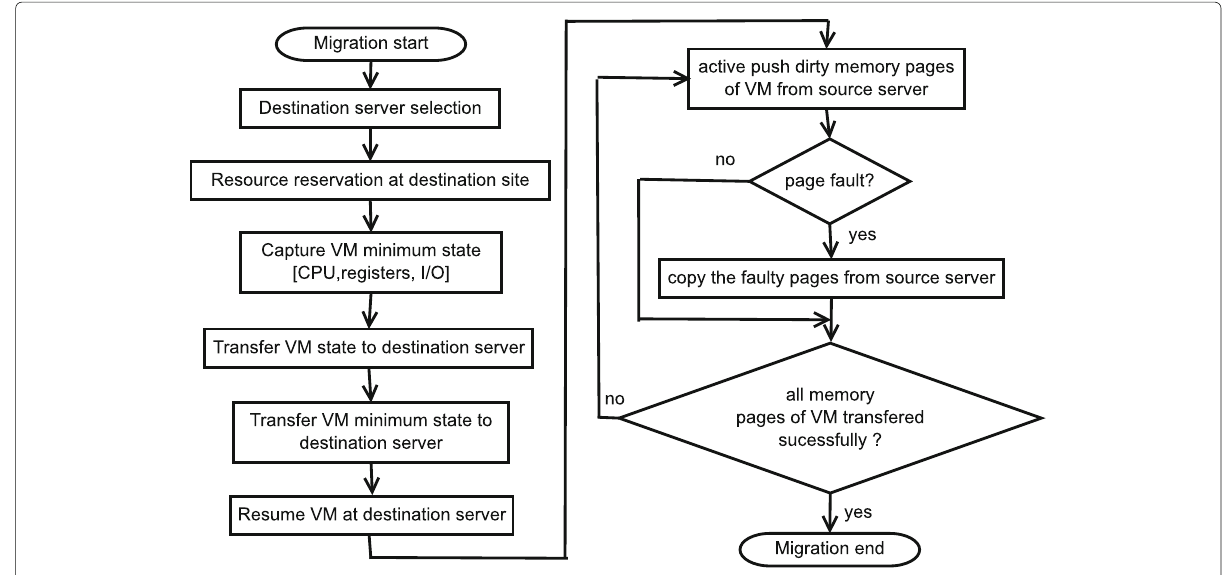
Fig. 3 Basic steps of VM migration follow in post-copy